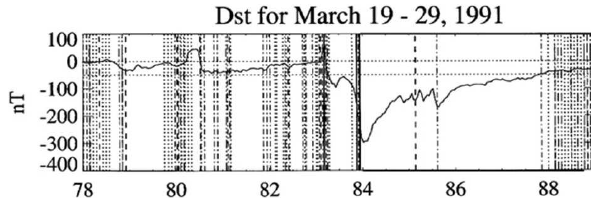
Fig. 1. D st trace for 19–29 March 1991. Vertical lines indicate times of EPB detections by the plasma density monitor on DMSP F9 near the 21:00LT